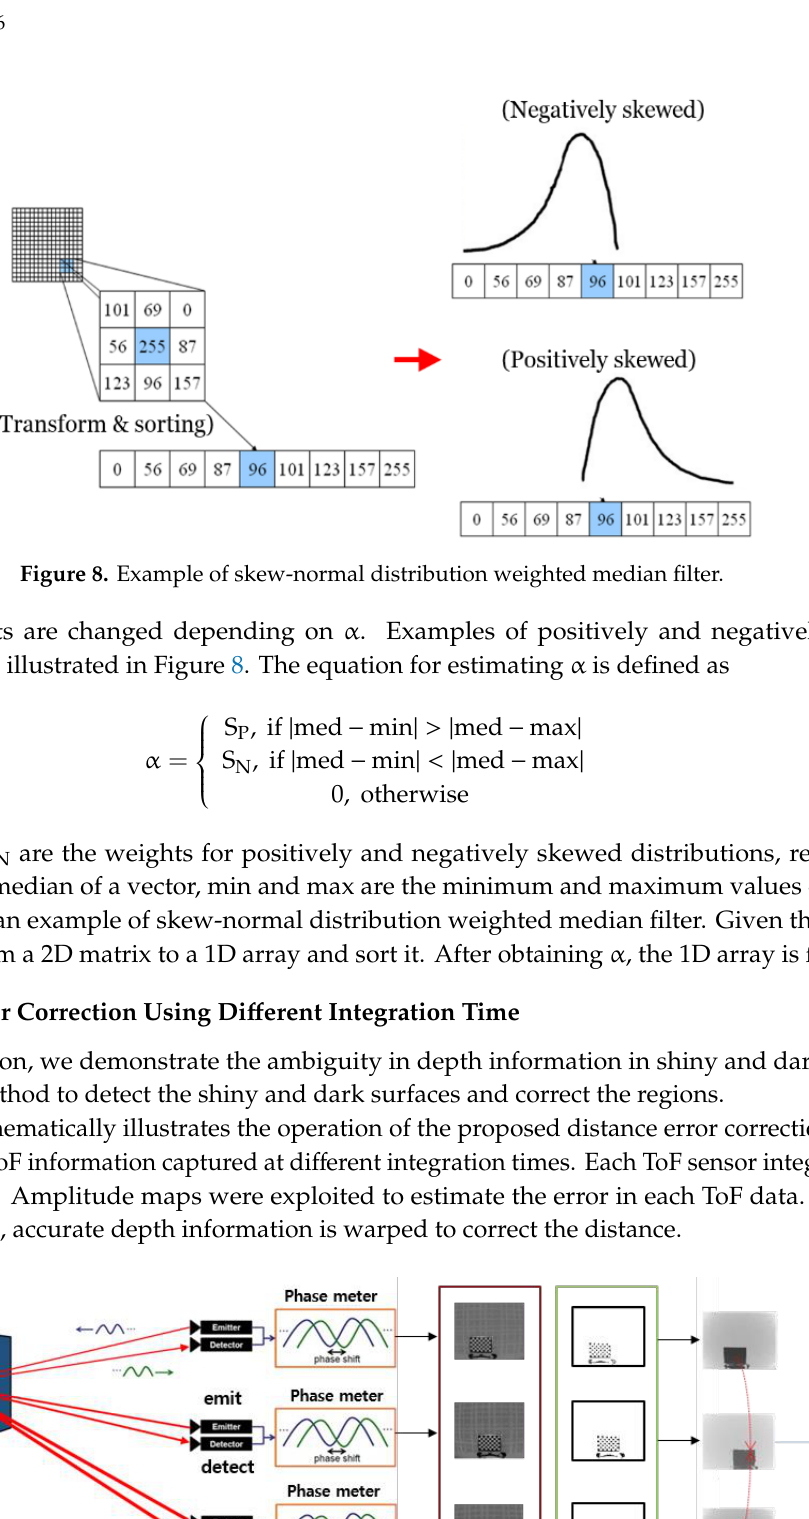
Figure 9. Operation of the proposed distance error correction method.